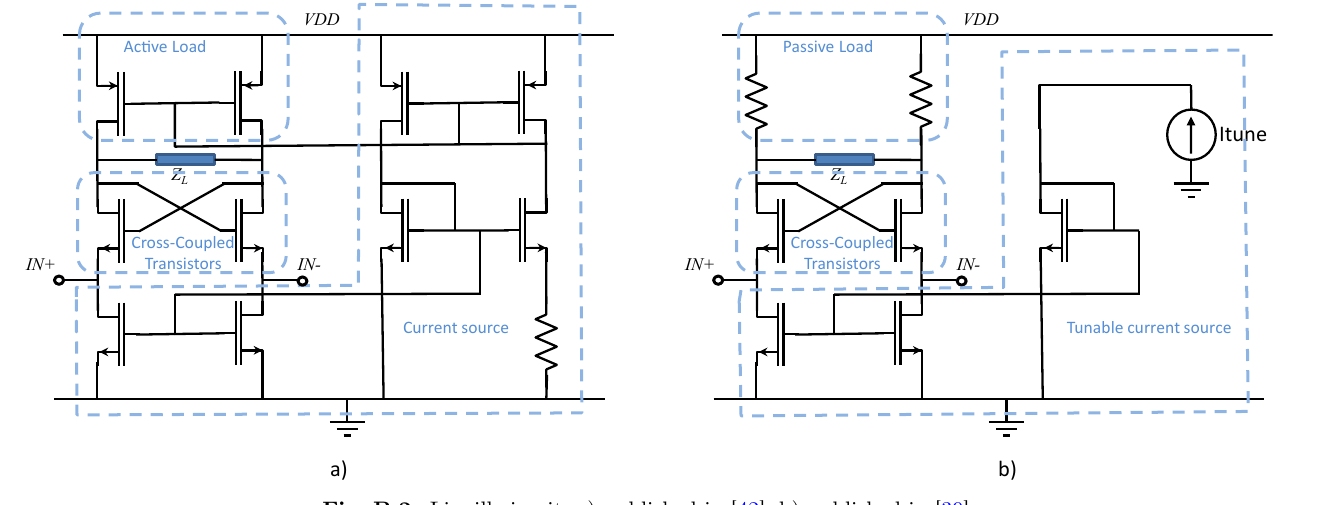
Fig. B.2. Linvill circuit: a) published in [42], b) published